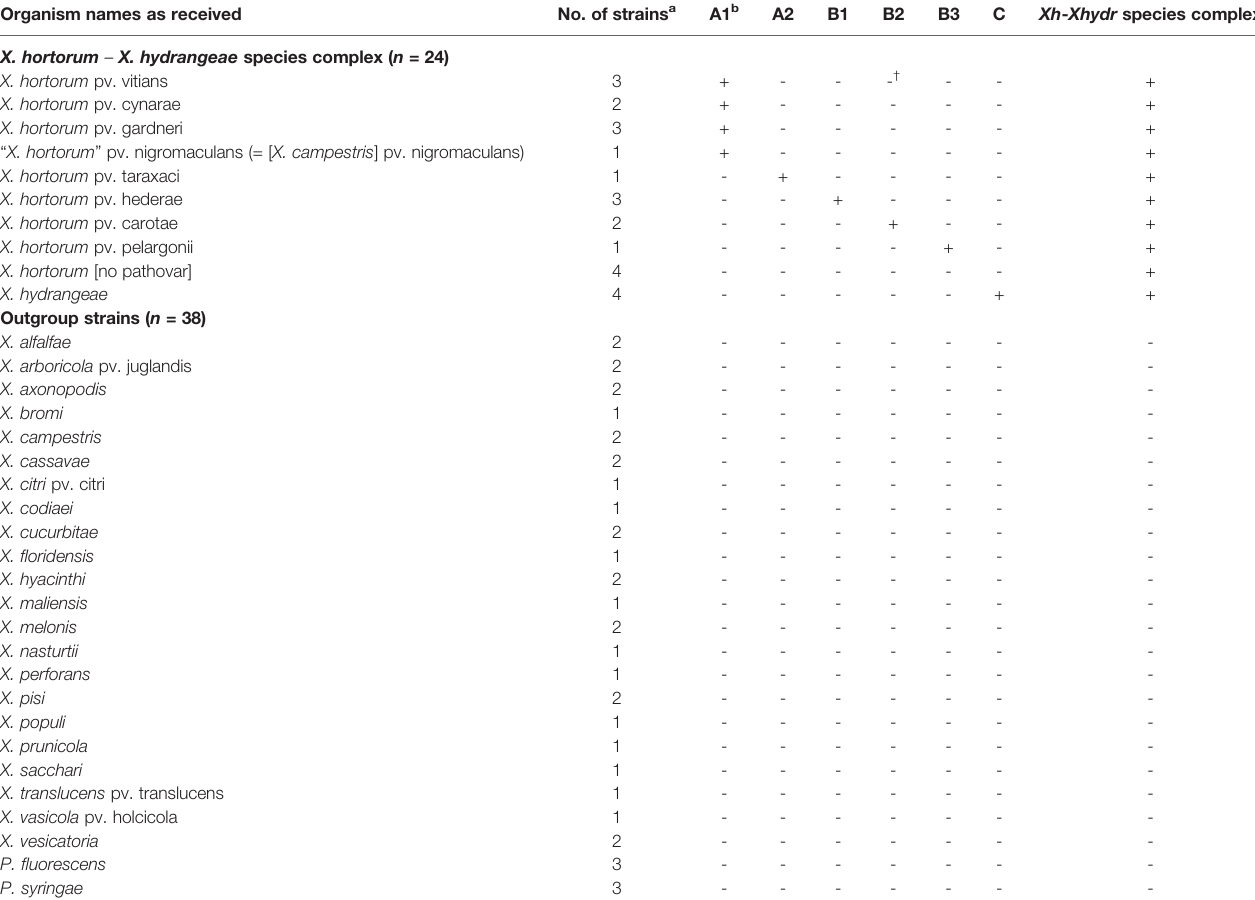
TABLE 2 | Reference strains used in this study and results of the LAMP assays based on their normalized genomic DNA. Selective ampli fi cation is marked with a sign “ + ” , and “ - ” denotes absence of ampli fi cation. Organism names as